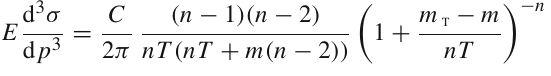
of-bunch pileup correction has to be noted for completeness and to be applied as